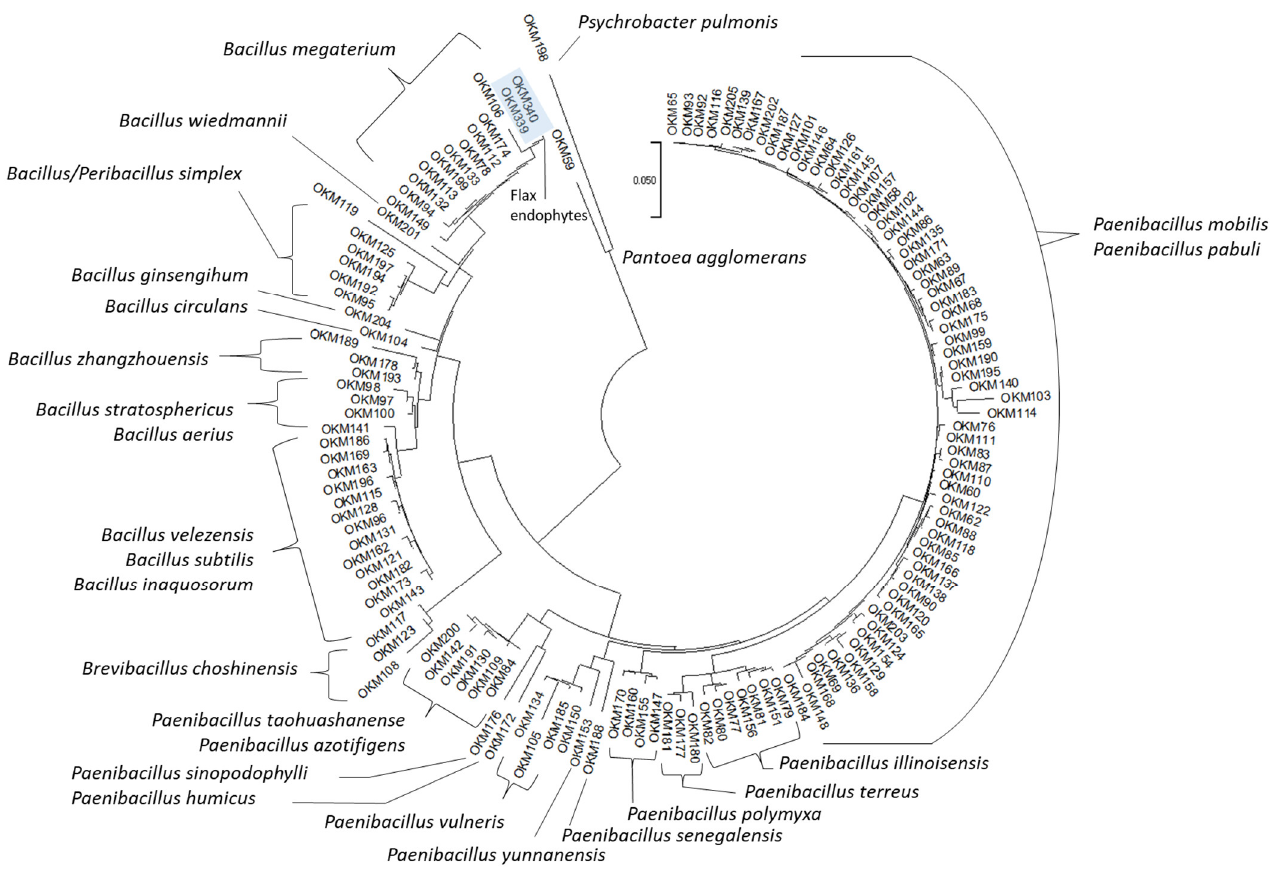
Figure 2. Nearest-Neighbor Phylogenetic Tree of 16S Amplicons from Culturable Seed-Borne Bacterial Endophytes. Amplicons were aligned using the MUSCLE algorithm prior to nearest-neighbor phylogenetic tree construction using the Tamura–Nei model on MEGA software (Version 11.0.11).